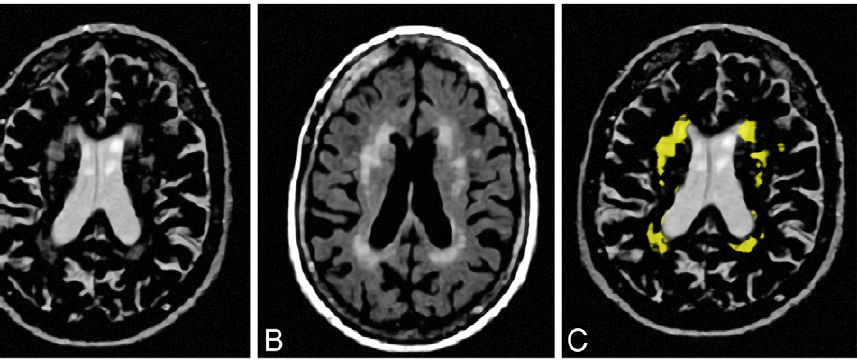
Figure 2. The segmentation process using SNIPER (Software for Neuro-Image Processing in Experimental Research). T2-weighted image ( a ) and FLAIR image ( b ). Result of automated segmentation process based on both sequences ( c ).